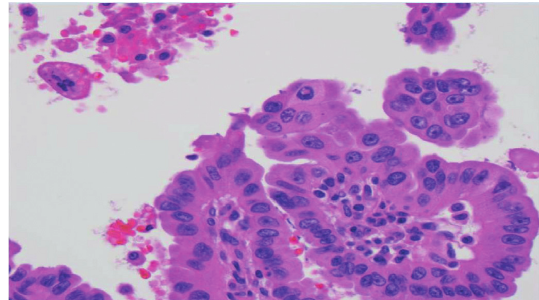
Figure 5: Hematoxylin and eosin stain. The tumor consisted of papillae lined by cells with the hallmark nuclear features of pap- illary thyroid cancer, such as nuclear grooves and pseudoinclu- sions. No psammoma bodies were seen. Overall, the histologic appearance was consistent with metastatic papillary thyroid